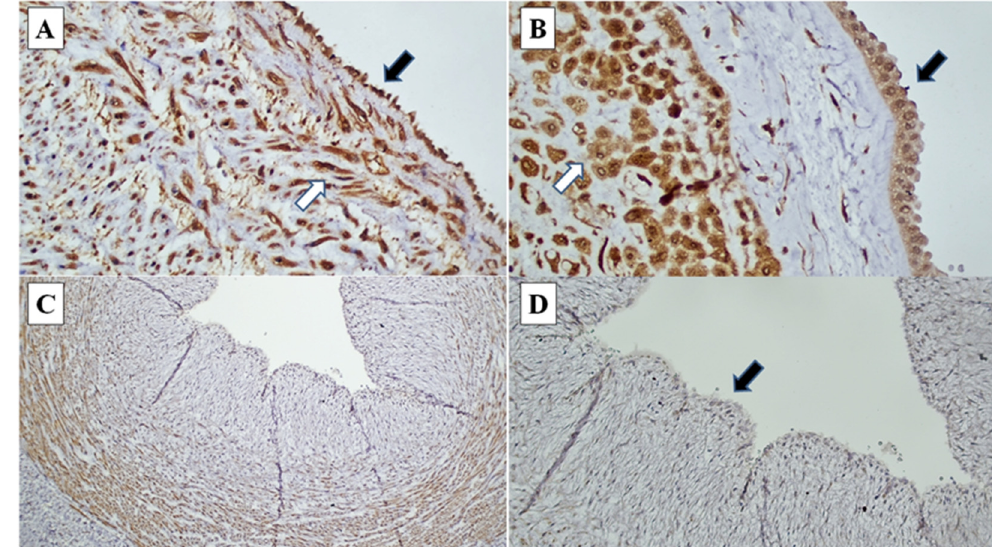
Figure 2. CXCR1 immunohistochemistry in chorioamnionitis: ( A ) Umbilical cord endothelial cells (black arrow) and umbilical cord blood vessel smooth muscle wall (white arrow) demonstrating strong intensity staining (CXCR1, ×200). ( B ) Amnion epithelial cells (black arrow) and decidual cells at decidual capsularis (white arrow), demonstrating strong intensity staining (CXCR1, ×400). ( C ) and ( D ) Loss of CXCR1 immunoexpression in umbilical cord endothelial cells (black arrow) (CXCR1 ×40, ×200). Table 4. Logistic regression analysis with foetal death as the dependent variable against various independent variables in chorioamnionitis.